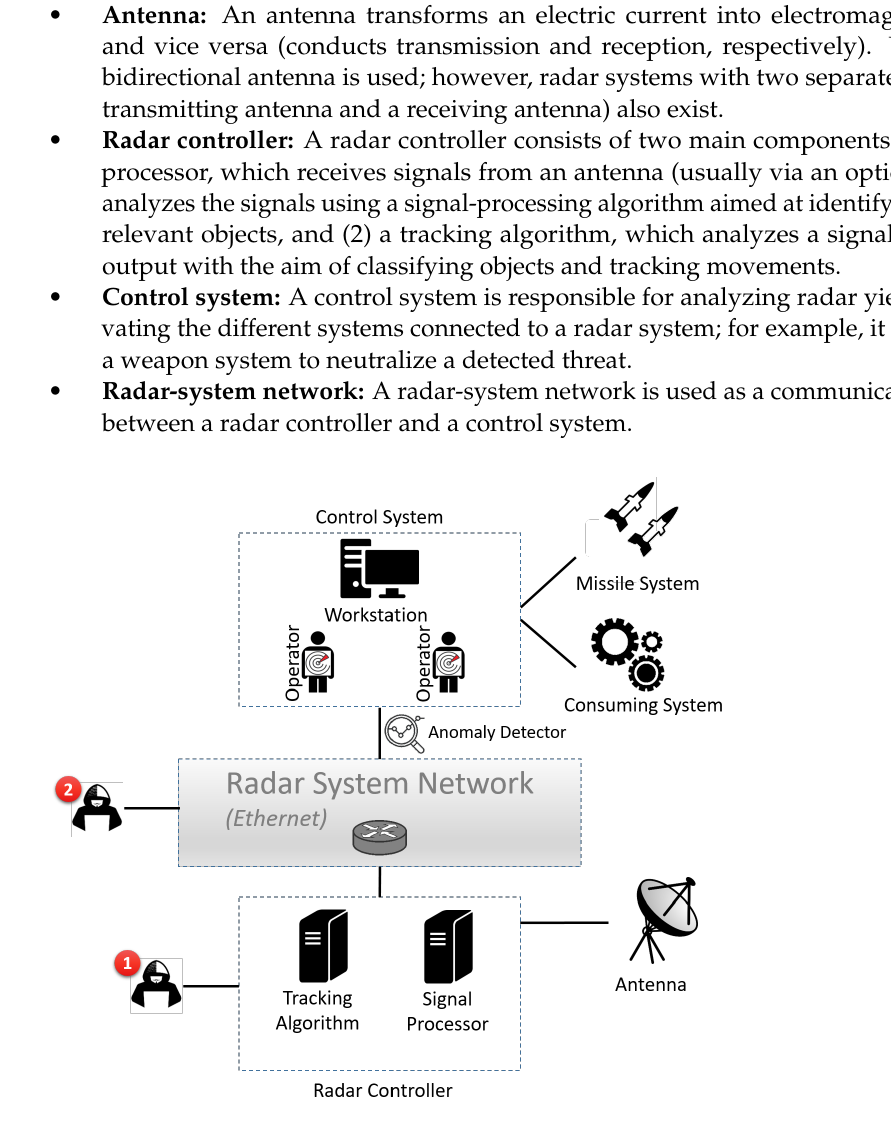
Figure 1. An example of a typical radar-system architecture. The red circles indicate our assumed adversary’s locations. Our proposed anomaly-detection method is located at the link between the radar system and the consuming